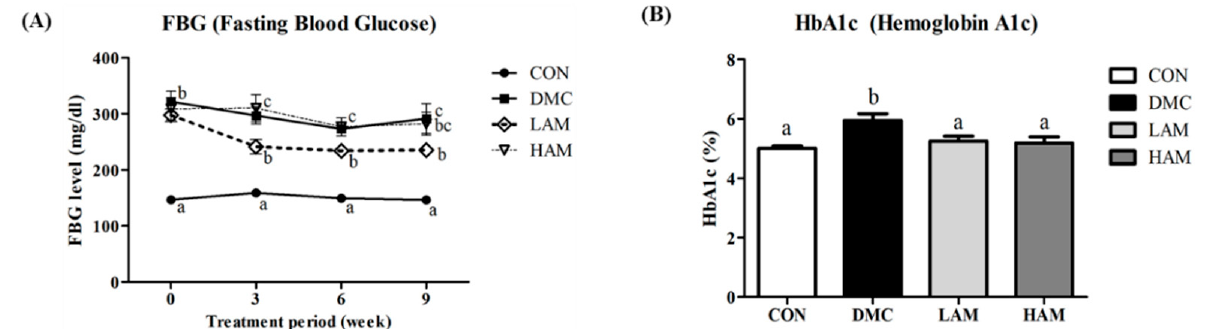
Figure 2. Effects of AME on ( A ) fasting blood glucose and ( B ) hemoglobin A1c (HbA1c) levels in T2DM mice All values are reported as mean and SEM. Values with the different superscript letter were significantly different ( p < 0.05; ANOVA with post-hoc Duncan’s multiple range test). n = 10~11 mice in each group CON, normal control group (negative control); DMC, type 2 diabetic control group (positive control); LAM, diabetic group supplemented with low dosage (50 mg/kg BW) of AME; HAM, diabetic group supplemented with high dosage (100 mg/kg BW) of AME.